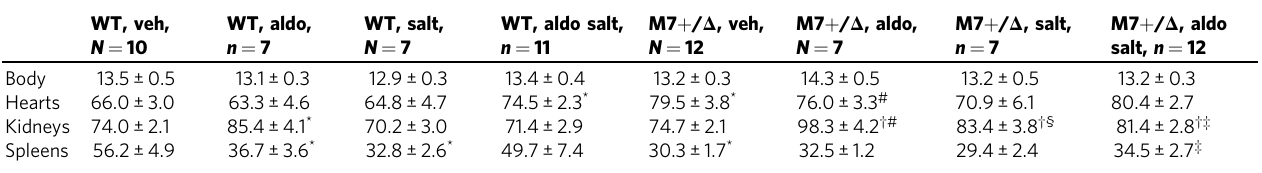
Body (g) and organ weight (mg) were normalized by tibia length (cm). Data is expressed as mean±SEM. * p <0.05 vs WT veh; † p <0.05 vs M7 + / Δ veh; ‡ p <0.05 M7 + / Δ aldo-salt vs WT aldo-salt; # p <0.05 M7 + / Δ aldo vs WT aldo; § p <0.05 M7 + / Δ salt vs WT salt.